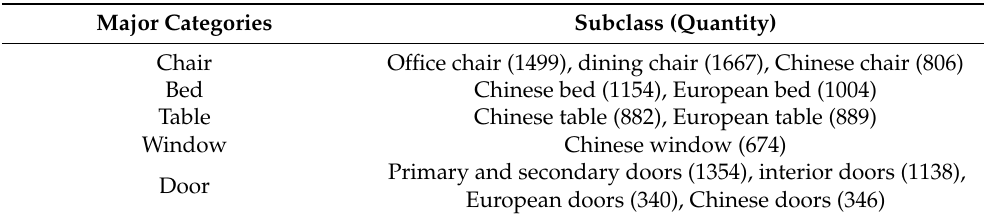
Table 1. Breakdown of the major and minor categories of furniture images.